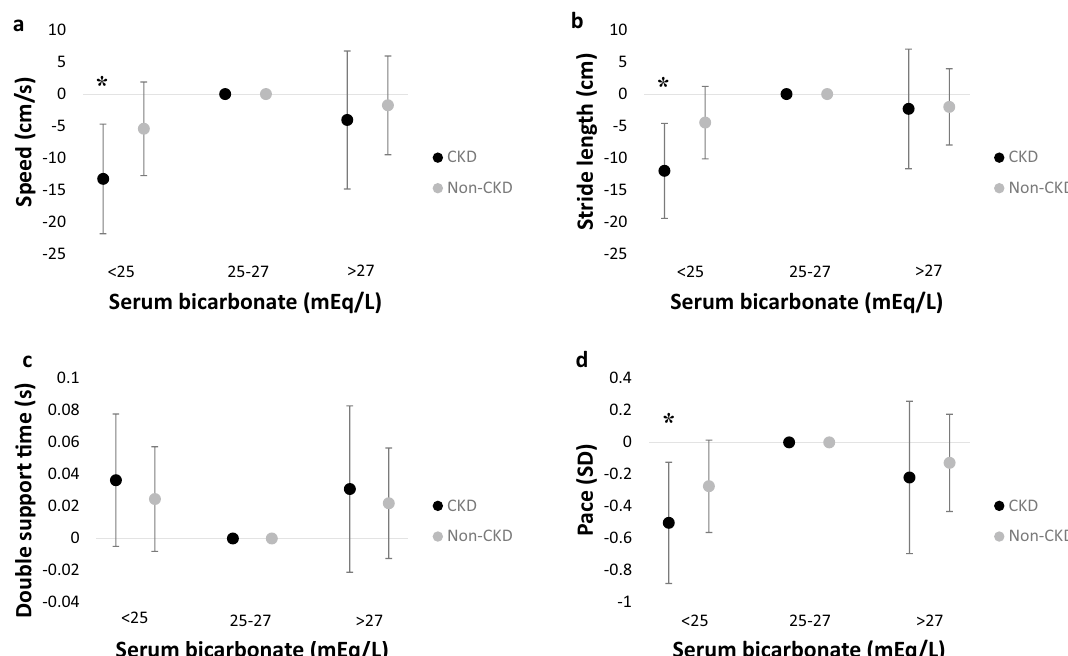
Figure 3. Associations of serum bicarbonate tertiles with gait markers by chronic kidney disease (CKD) status. Multivariable linear regression was performed on ( a ) gait speed, ( b ) stride length, ( c ) double support time, and ( d ) pace for CKD (n = 131) and non-CKD (n = 192) participants. The reference group was serum bicarbonate 25–27 mEq/L (middle tertile). CKD was defined as estimated glomerular filtration rate (eGFR) < 60 mL/ min per 1.73 m 2 . Models were adjusted for age, sex, race, education, smoking status, body mass index (BMI), number of comorbidities, number of medications, diuretic use, diagnosis of neuropathy, cardiovascular disease, hypertension, diabetes, emphysema or chronic obstructive pulmonary disease (COPD), blood urea nitrogen (BUN), and eGFR. Error bars denote 95% confidence intervals. Asterisks denote P < 0.05. Serum bicarbonate < 25 mEq/L (CKD n = 58, non-CKD n = 54), 25–27 mEq/L (CKD n = 50, non-CKD = 94), > 27 mEq/L (CKD n = 23, non-CKD n = 44). CKD chronic kidney disease, SD standard deviation. N = 323